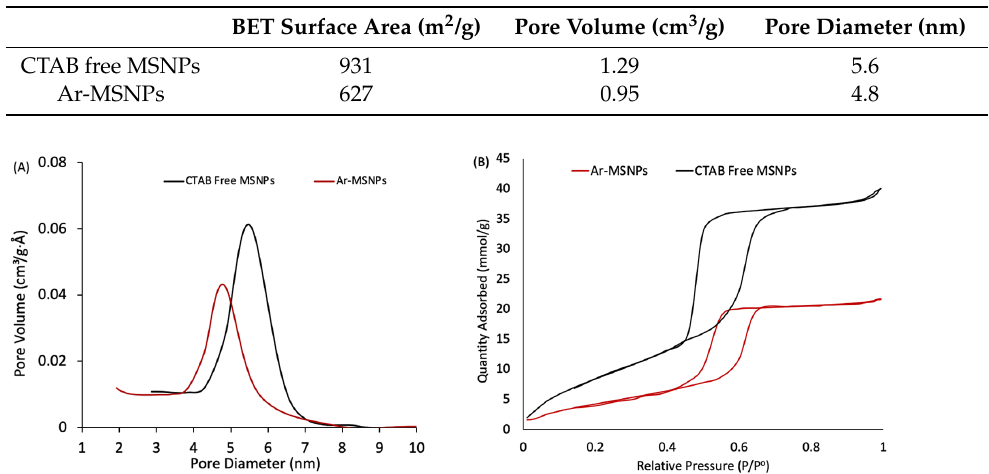
Table 1. Physical properties of CTAB free MSNPs and Ar-MSNPs obtained from N 2 adsorption/desorption studies.